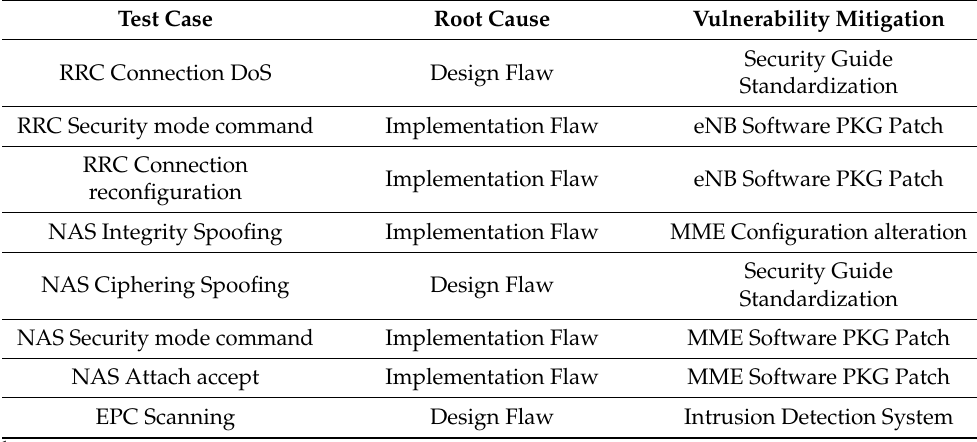
Table 8. Vulnerability mitigation 1